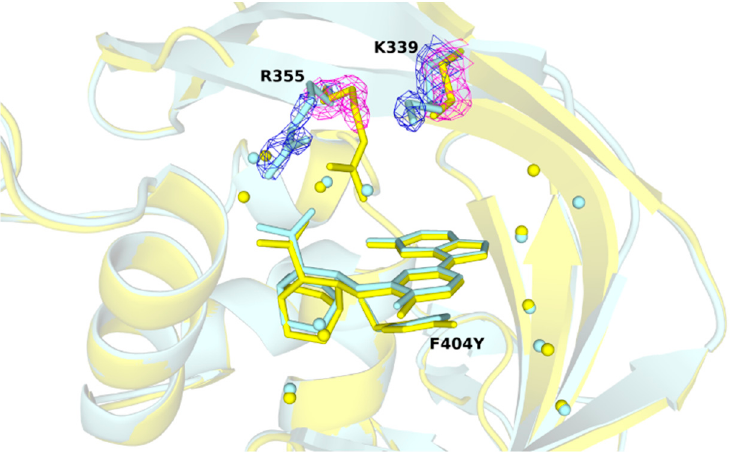
Figure 4. Comparison of the R355 and K339 positions in wild-type and F404Y variant. Bound pimodivir to PB2-WT (pale cyan) and PB2-F404Y (yellow) retain at a close position (RMSD: 0.12 Å). Water molecules are shown as spheres, residue R355 and K339 are shown in stick representation. Details of the 2F o –F c electron density maps (both contoured at 1.5 σ ) are in blue mesh–for PB2-WT, and magenta mesh for PB2-F404Y.